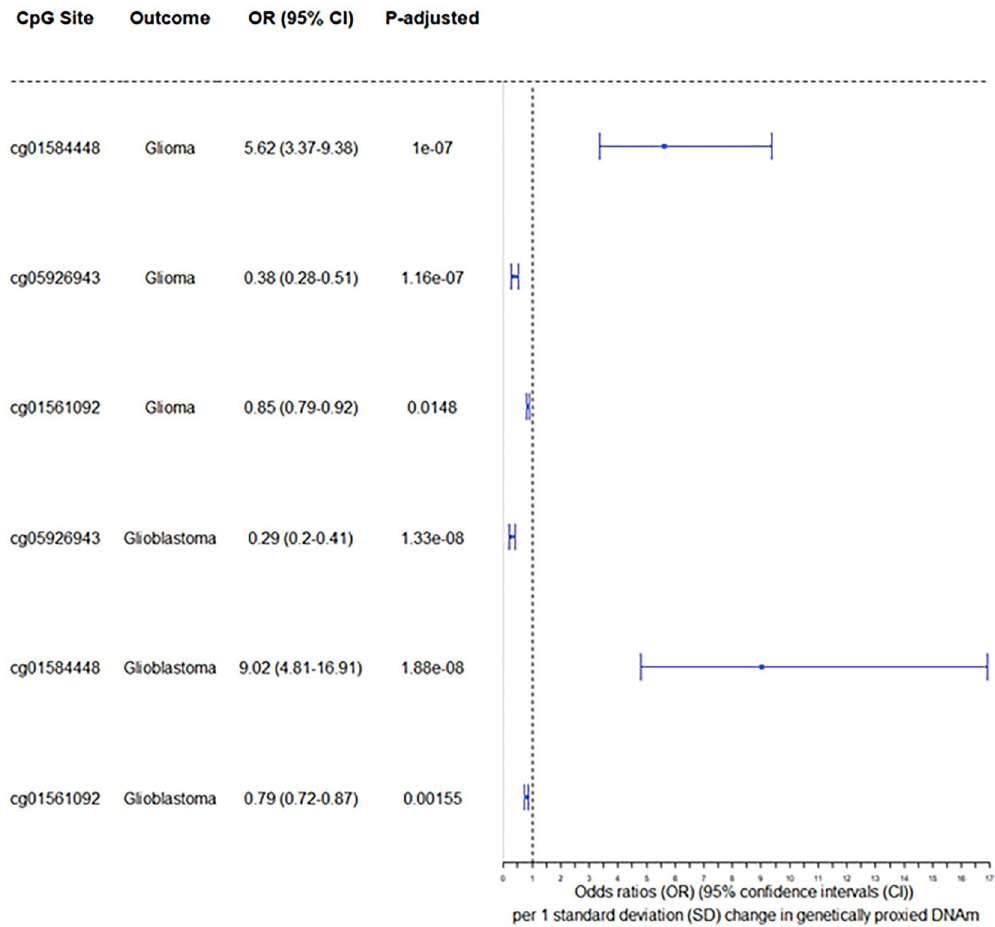
Figure 2. CpG sites that showed robust evidence of a causal role on glioma risk. Forest plot of CpG sites that showed robust MR evidence of an association with glioma or glioblastoma and colocalized with glioma or glioblastoma. OR, per standard deviation change in genetically proxied DNA methylation; 95% CI, 95% confidence intervals; p-adjusted, p-value adjusted for FDR for the observed effect.